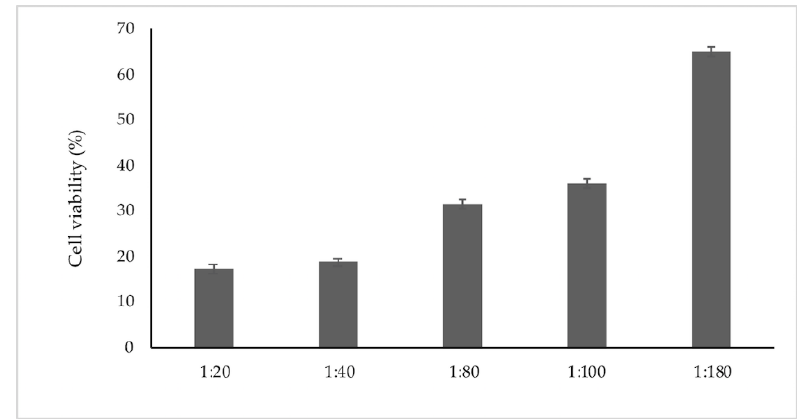
Figure 3. Viability of Caco-2 cells exposed to Fluorescein isothiocyanate-NLCs (FITC-NLCs) (1:20 to 1:180), for 2 h.